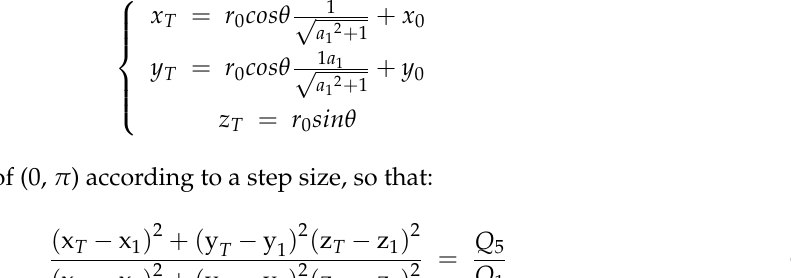
Figure 6. Schematic of human ‐ computer interaction (HCI) system based on the electrostatics of the human body. We designed a top ‐ level human–computer interaction system based on the electrostatics of the human body, built the hierarchical architecture, and divided the entire human–computer interaction system into physical, information, and application layers. The physical layer is the physical basis of the whole system, including the sensing circuits and signal processing circuit hardware. The information layer processes the signals from the physical layer, and mainly performs model and algorithm research, including solving for the position information of the charge sources according to